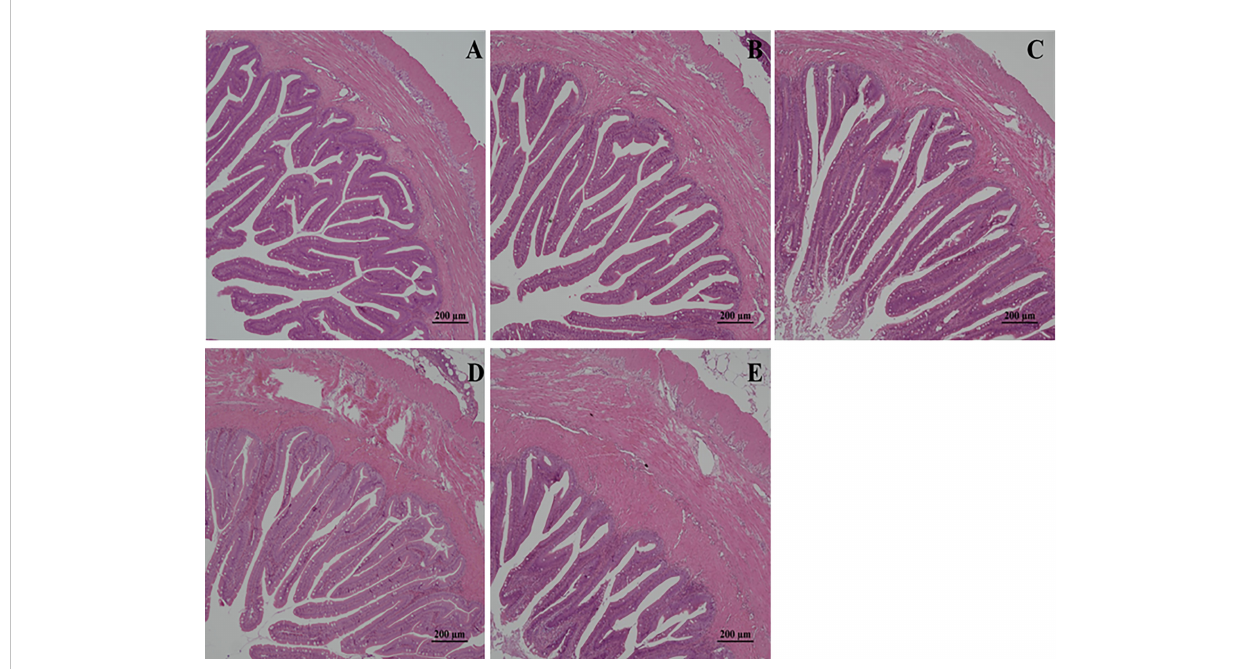
FIGURE 1 Effects of low-temperature stress on intestinal tissue of juvenile golden pompano. (A) was the control group, (B) was the low-temperature stress for 1 d, (C) was the low-temperature stress for 4 d, (D) was the low-temperature stress for 7 d, and (E) was the low-temperature stress for 14 d. The magni fi cation scale is